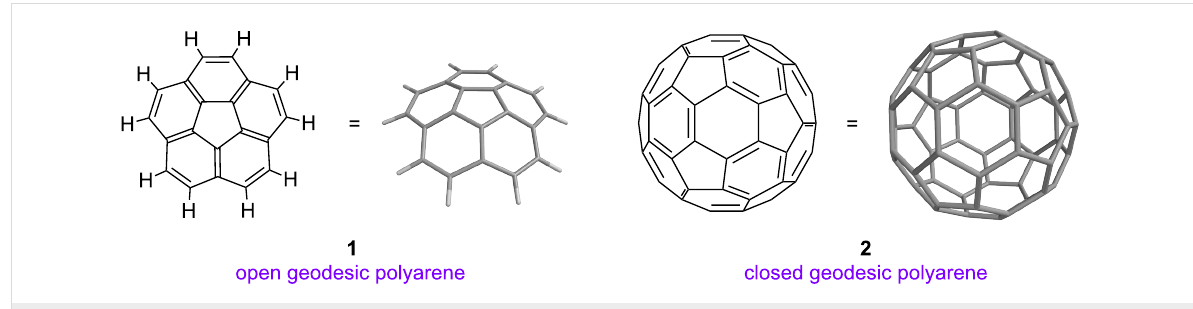
Figure 1: Prototypical open and closed geodesic polyarenes.